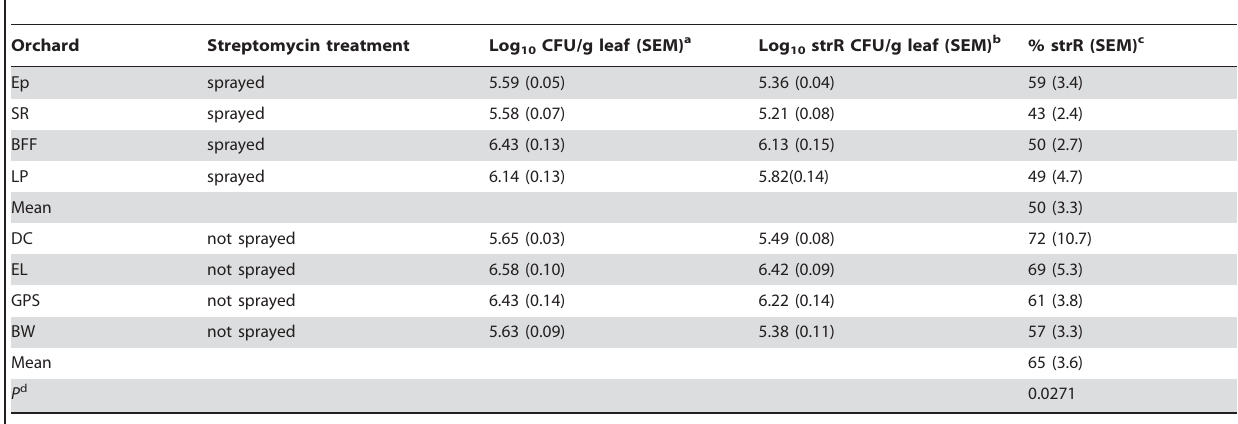
Table 2. Bacterial CFU recovered from the apple phyllosphere and percentage that were resistant to streptomycin (strR).